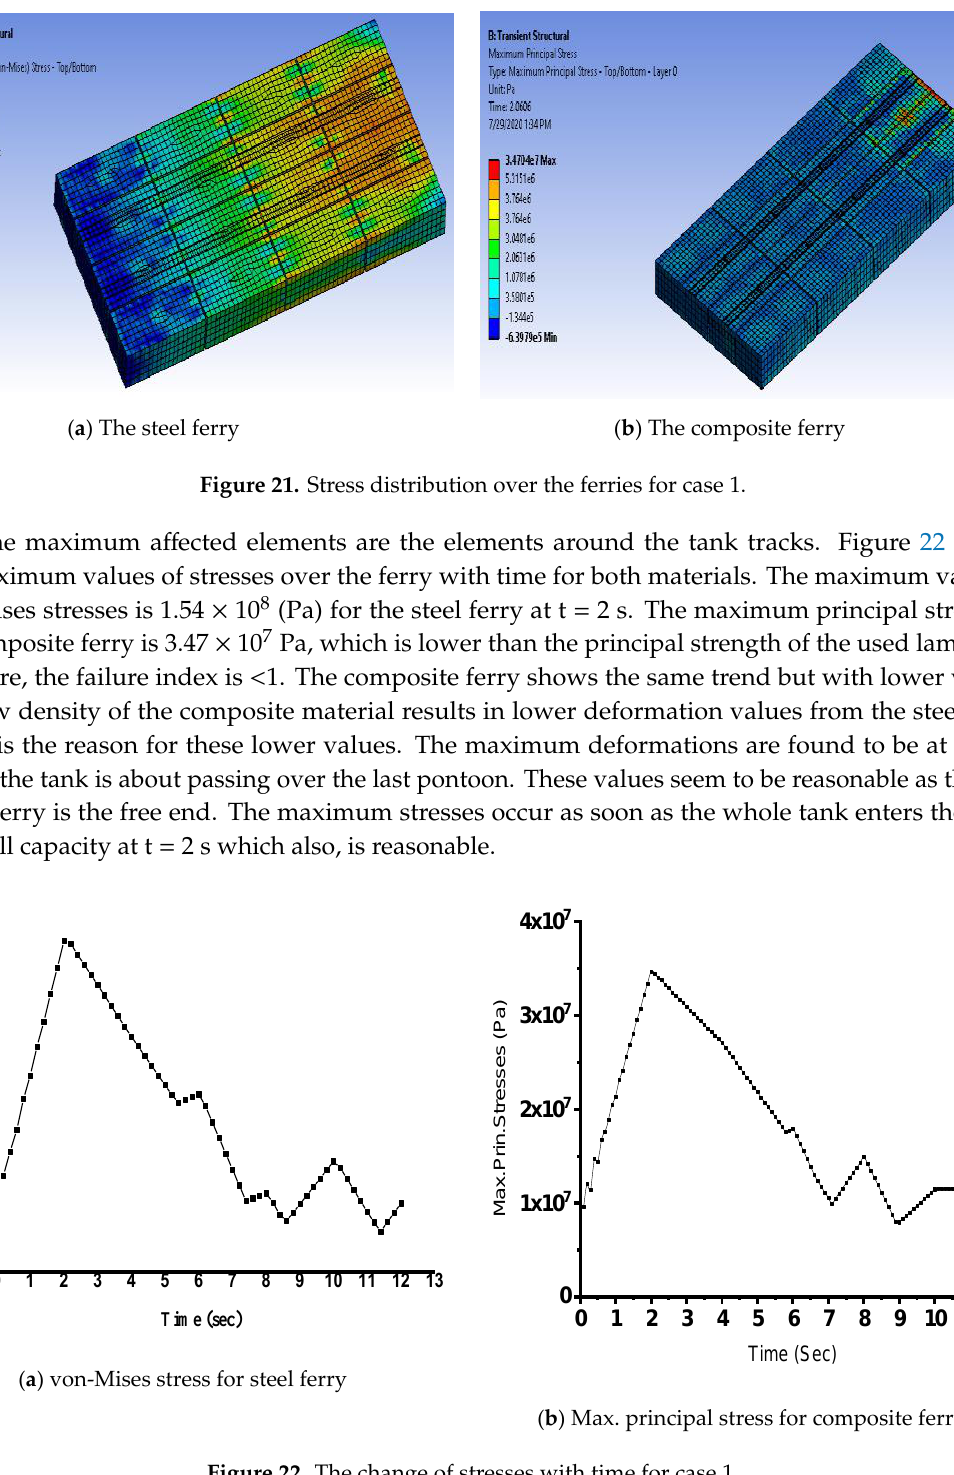
( b ) The composite ferry Figure 23. The total deformation distribution in case of loading 2. Figure 24 shows the total maximum deformation values with time all over the ferry for both materials. The figure illustrates that the maximum total deformation values have the same manner as the previous case in Figure 20 but with higher values. The total deformation values are increased in this case of loading by 7% for the steel ferry and about 9.5% for the composite ferry from the previous case.